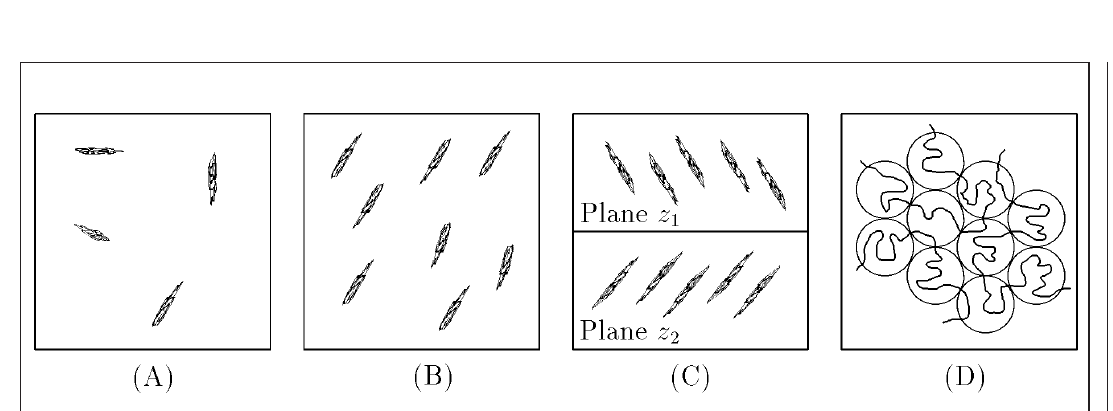
Figure 2: Schematic representation of different concentration ranges of the polyelec- trolyte solutions (A) strongly diluted solution without interaction between the polymer ions (B) diluted/semidiluted solution with interactions between the polymer ions (C) formation of a three- dimensional lattice structure (D) transition